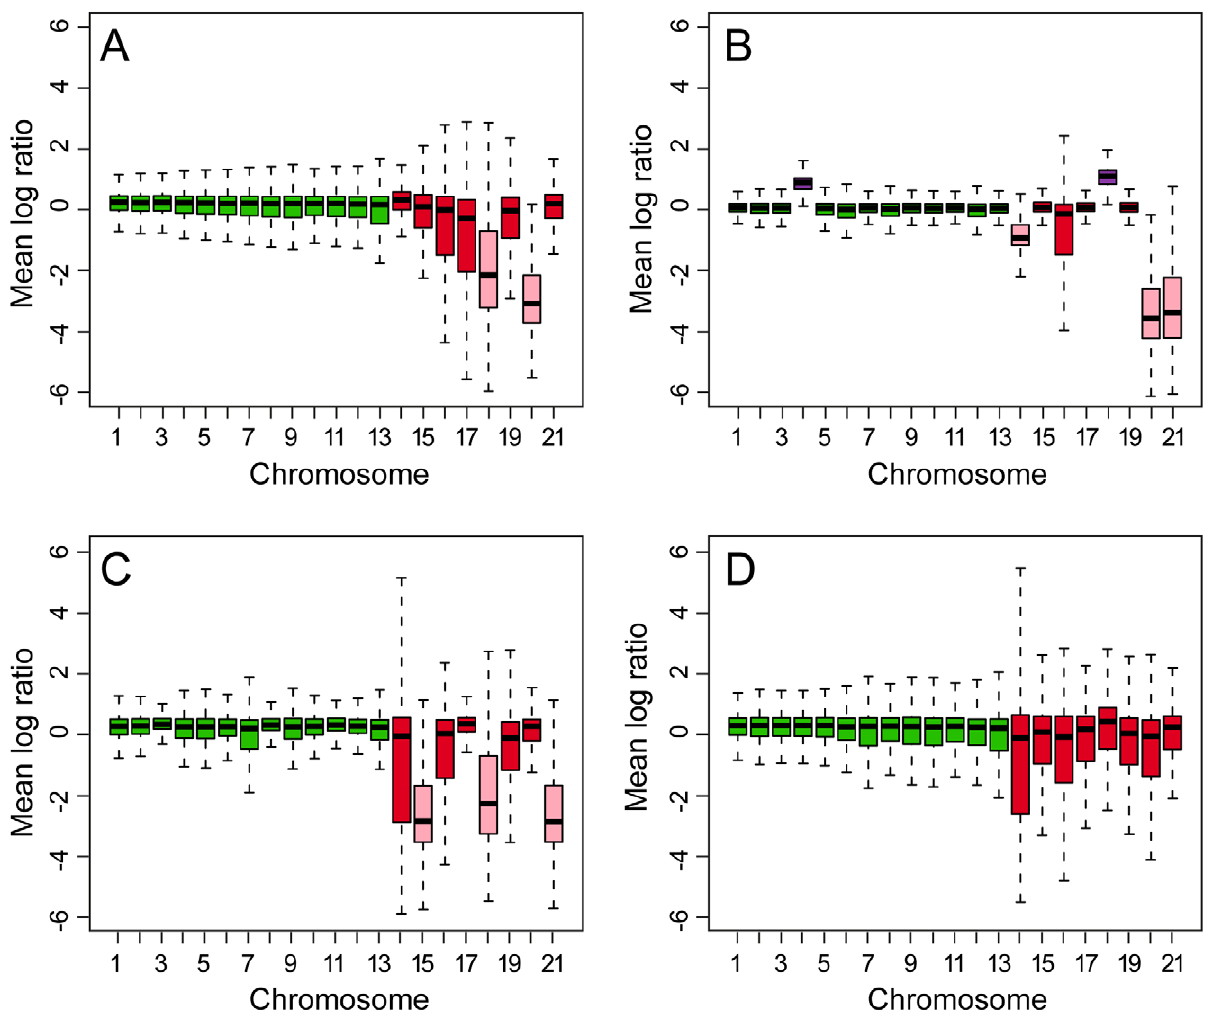
Figure 2. Box plots of comparative genome hybridizations (CGH) of DNA from five isolates of Mycosphaerellagraminicola to a whole- genome tiling array made from the finished sequence of isolate IPO323. A, CGH between IPO323 and the Dutch field isolate IPO94269. B, CGH between IPO323 and progeny isolate # 51 from the cross between IPO323 and IPO94269. C, CGH between IPO323 and progeny isolate # 2133 of the cross between IPO323 and IPO95052. D, CGH between IPO323 and Algerian field isolate IPO95052, which was isolated from and is adapted to durum (tetraploid) wheat. The genomic difference between the strains for each CGH is shown by 21 box plots, one for each chromosome of M. graminicola . The horizontal line in each box is the median log ratio of hybridization signals of the two strains; the upper and lower ends of a box represent the 25% and 75% quartiles. The whiskers extending from each box indicate 1.5 times the interquartile range, the distance between the 25% and 75% quartiles. The larger the deviation from 0, the greater the difference between the strains for a particular chromosome. Pink boxes that are significantly less than the zero line indicate missing chromosomes. The purple boxes in panel B (4 and 18) that are significantly higher than the zero line indicate chromosomes that are